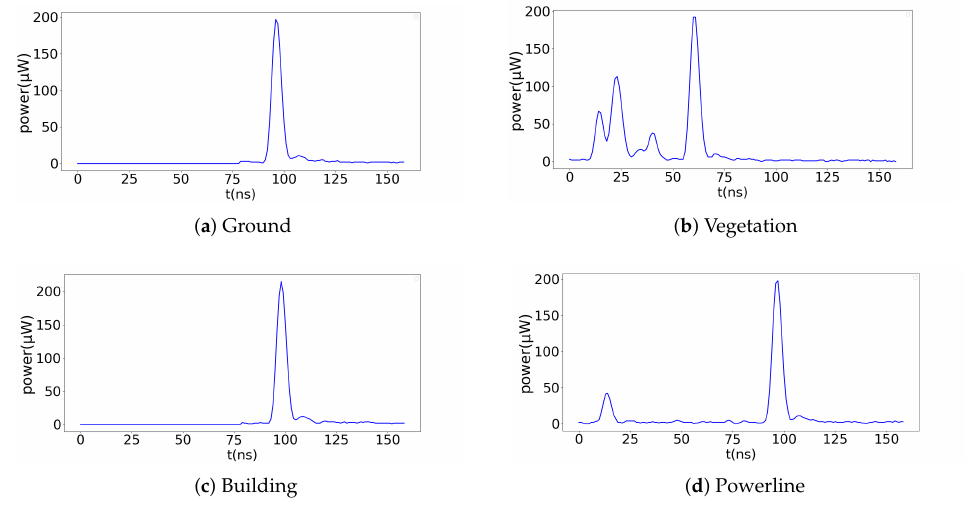
Figure 3. Urban full